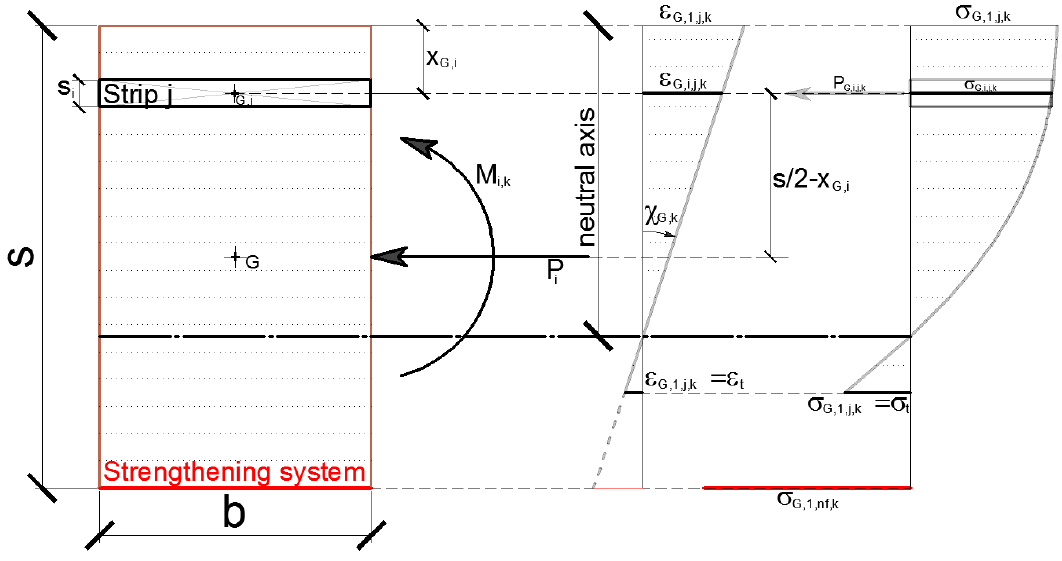
Figure A1. Discrete model to assess the bending moment-curvature diagram.